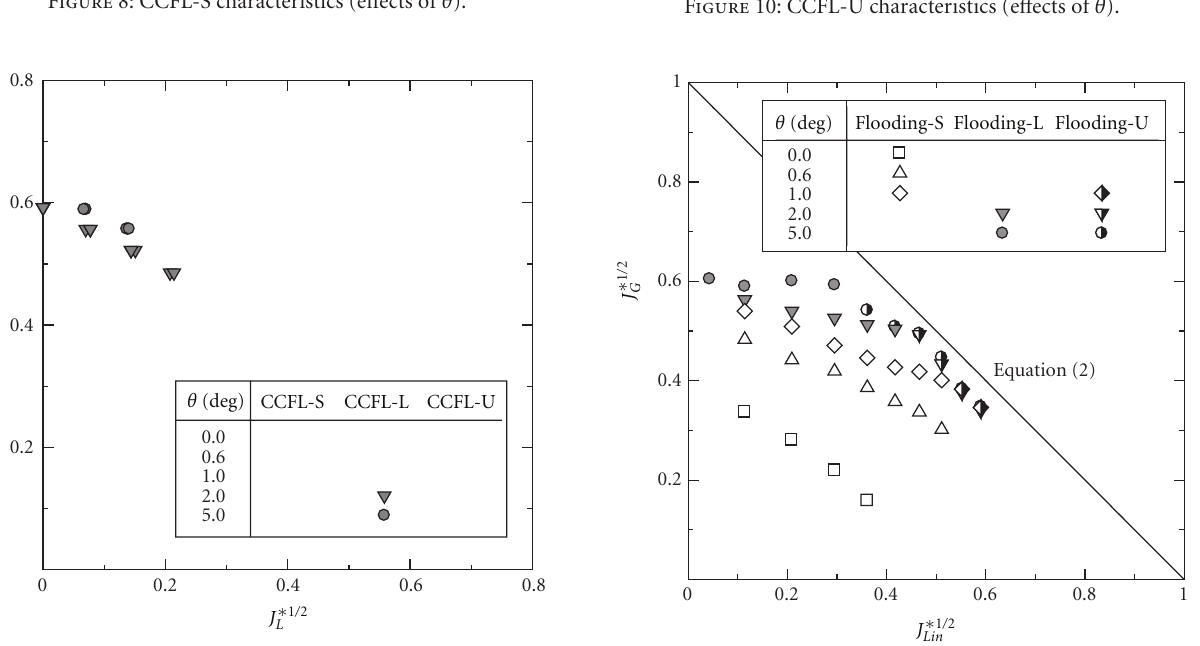
Figure 10: CCFL-U characteristics (e ff ects of θ ).